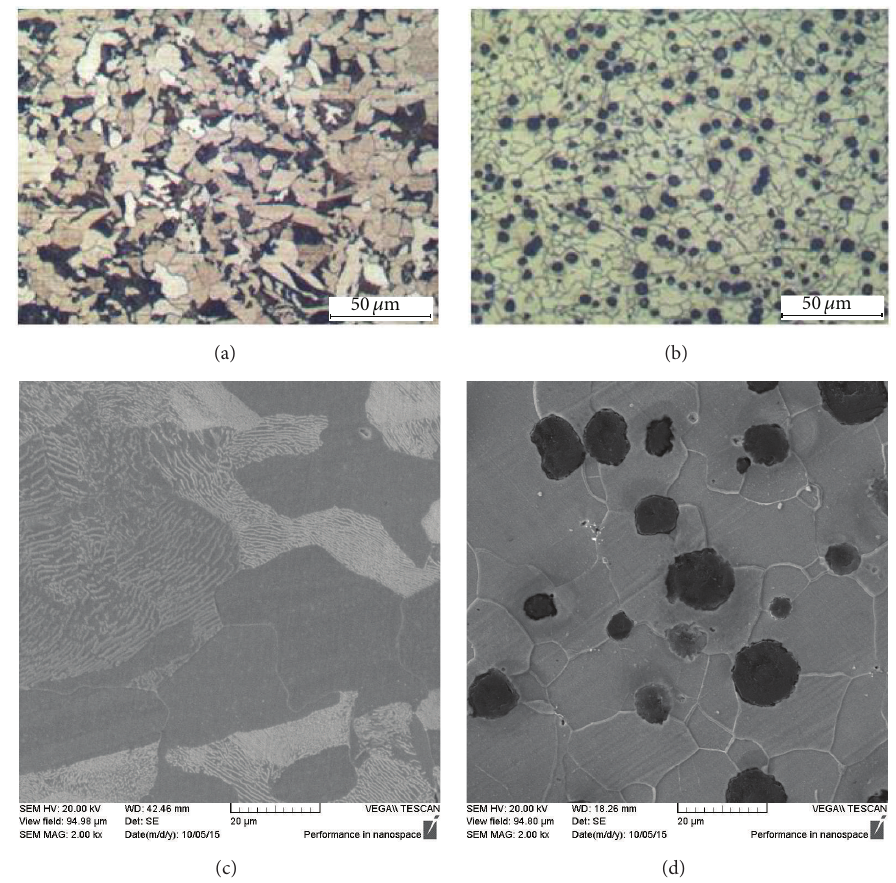
Figure 6: Optical microstructures (a, b) and SEM images (c, d); (a, c) carbon steel and (b, d) ductile cast